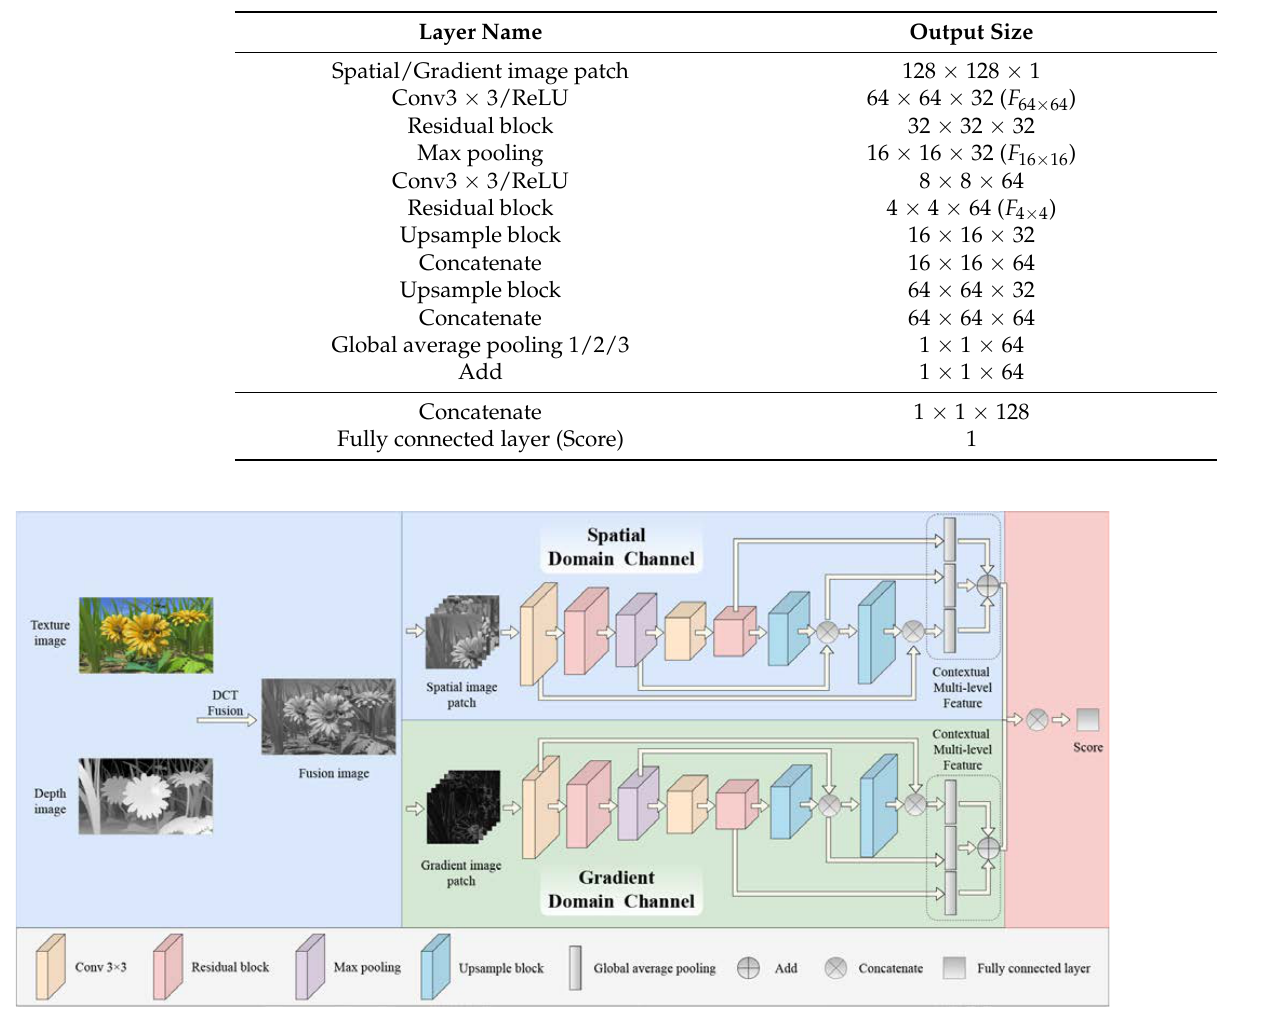
Figure 2. Two-channel convolutional neural network structure based on spatial-gradient domain.